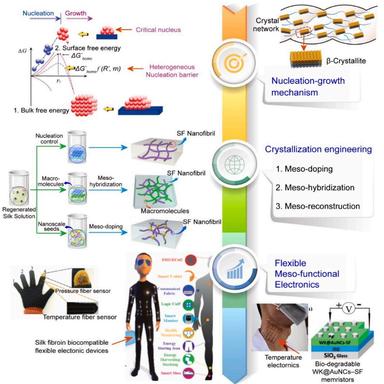
(a) Multilevel structures of crystal networks. (b) Scheme illustrating the four structural factors determining the performance of soft materials. Reproduced with permission . Copyright 2016, Wiley-VCH. (c) Hierarchical structure and crystal structures are identified in many natural materials such as wood and arthropod exoskeleton. Wood consists of a line chain of β-(1,4)-linked D-glucose units, and exoskeleton is made of a line chain of β-(1,4)-linked N-glucose units. The nanocrystal size of th